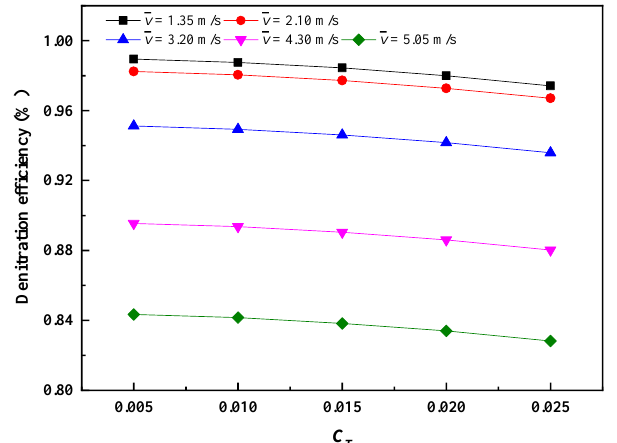
Figure 38. Relationship between relative standard deviation of temperature and denitration efficiency at velocity 3.2 m/s.